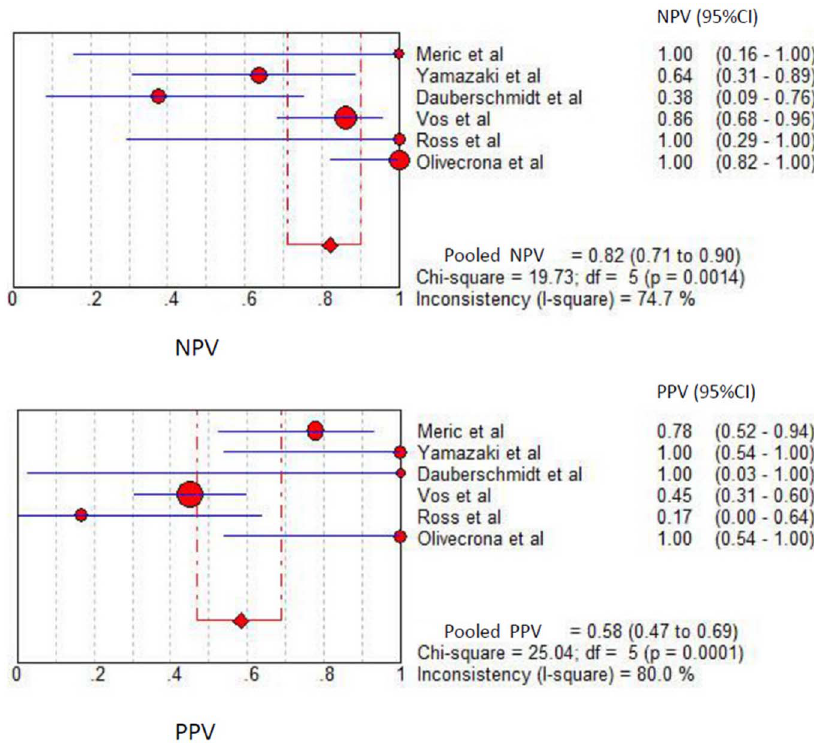
Figure 9. The pooled positive predictive value (PPV) and negative predictive value (NPV) to predict mortality in patients with traumatic brain injury.